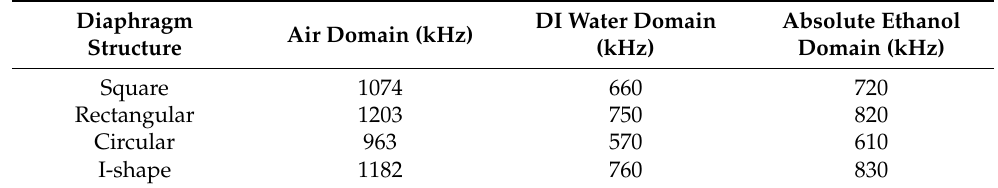
Table 3. The resonant frequencies of the pMUT with four composite diaphragms in the air, DI water, and absolute ethanol domains.